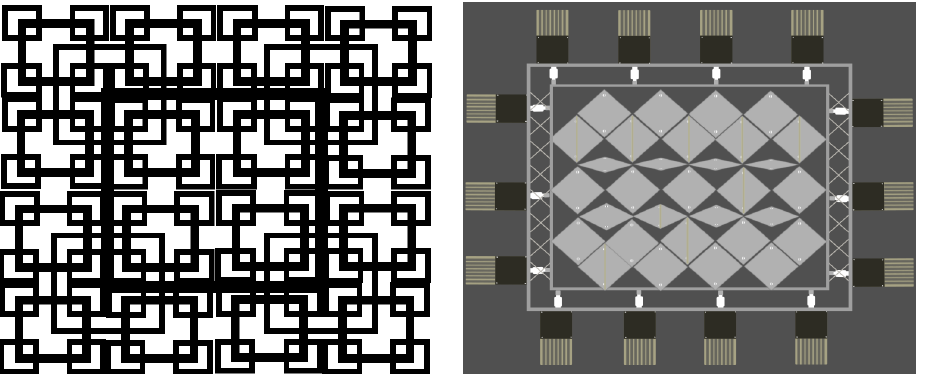
Figure 1. Examples of a passive fractal grid ( left , from [30]) and of an active grid ( right , from [30]) used in wind tunnel